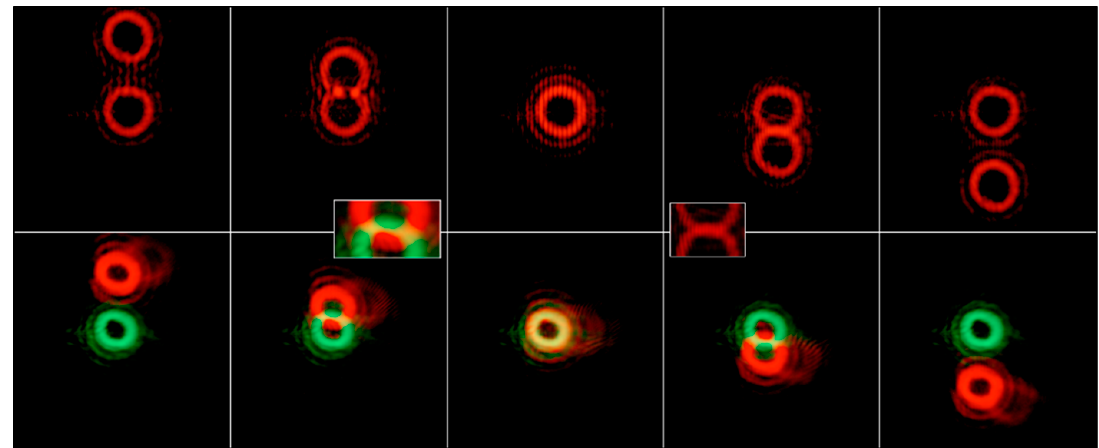
Figure 11. Left to right: vortices passing through each other. Above, red vortices pass through each other and interfere. Below, red and green vortices pass through each other and superimpose to make yellow. The insets show a close-up view of the overlap regions.